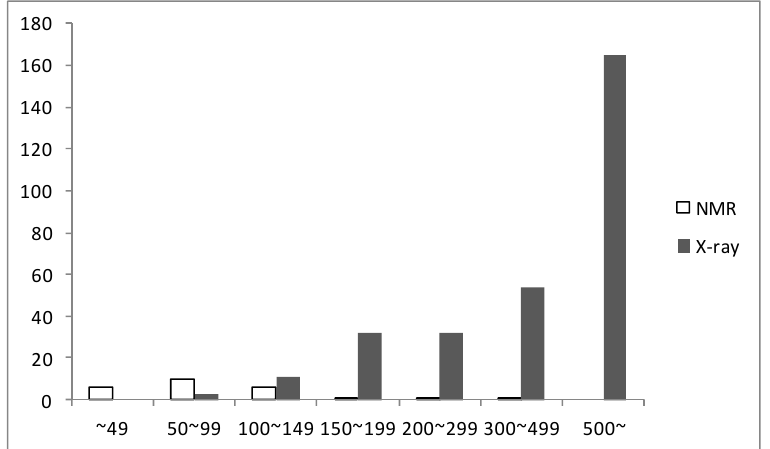
Figure 2. The number of structures determined by X-ray and NMR according to the